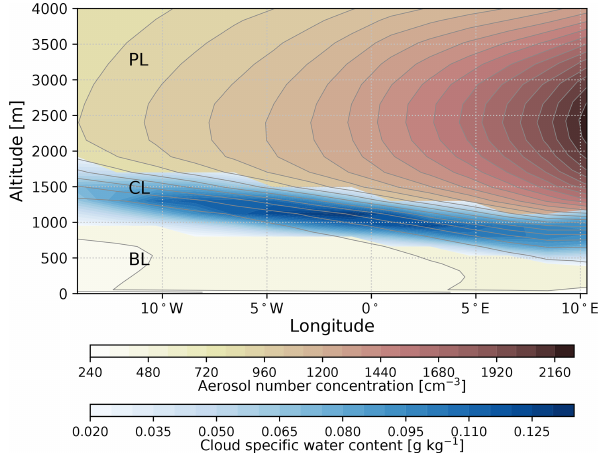
Figure 2. UKESM1-simulated mean vertical profiles of cloud spe- cific water content (gkg − 1 ) and aerosol number concentration (cm − 3 ) at standard temperature and pressure (STP) in the cloud box region during BB season. BL, CL, and PL represent the bound- ary layer, cloud layer, and plume layer respectively. The cloud layer is identified as the layer with a specific liquid water content > 0 . 02gkg − 1